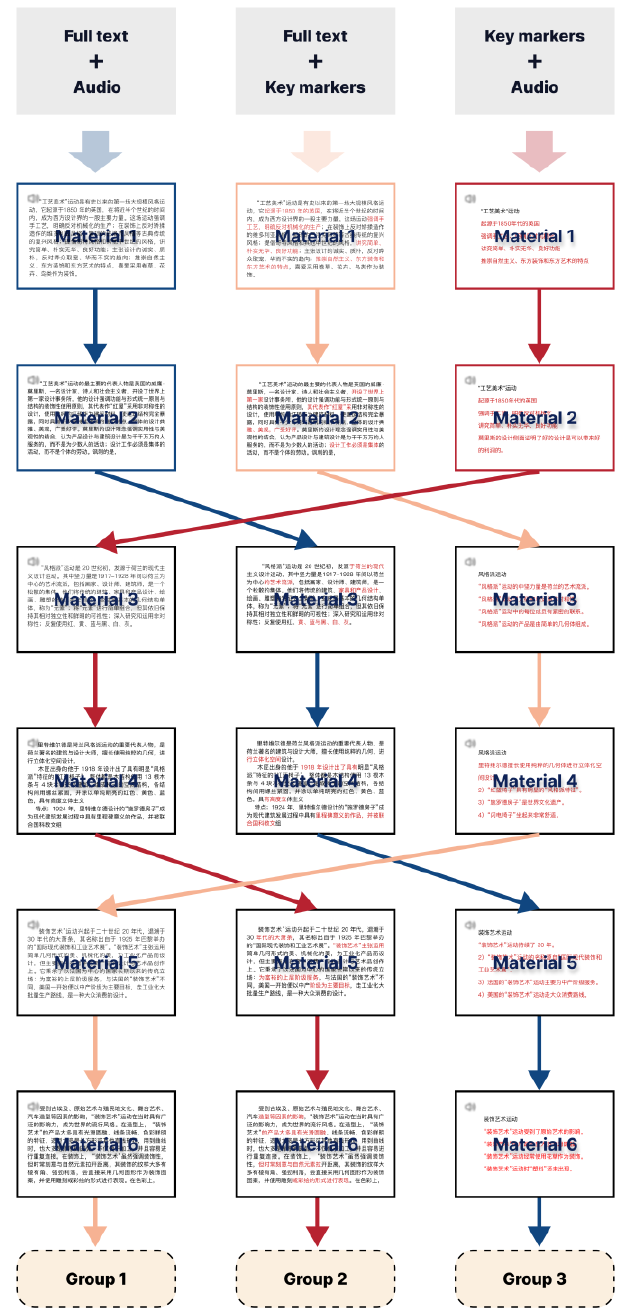
Figure 6. Experimental phase I procedure.